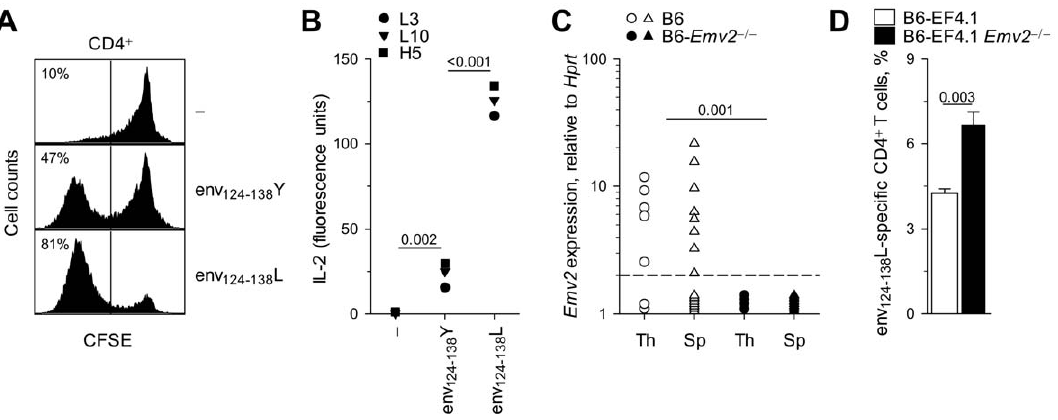
Figure 2. Emv2 selects against a fraction of env 124-138 L-specific CD4 + T cells. (A) Dilution of prior CFSE label by primary EF4.1 CD4 + T cells incubated for three days in vitro in the absence of peptide stimulation (-) or in the presence of 10 2 5 M env 124-138 L or env 124-138 Y peptides. Numbers within the plots denote the percentage of CFSE 2 cells and are representative of 4 mice per condition. (B) IL-2 production by three env 124-138 L-specific hybridoma T cell lines in response to in vitro stimulation with the same peptides at 5 6 10 2 6 M. (C) Emv2 transcription, relative to Hprt transcription, in thymi (Th) and spleens (Sp) of wild-type B6 or Emv2 -deficient B6 mice (B6- Emv2 2 / 2 ). Each symbol is an individual mouse. The dashed line represents the limit of detection. (D) Frequency of env 124-138 L-specific cells in primary CD4 + T cells from B6 (B6-EF4.1) or Emv2 -deficient B6 (B6-EF4.1 Emv2 2 / 2 ) EF4.1 mice. Data are the means 6 SEM ( n =9) from 3 experiments.